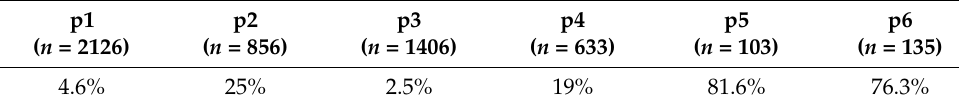
Table 4. Grabbing ratio in the ascent motion.